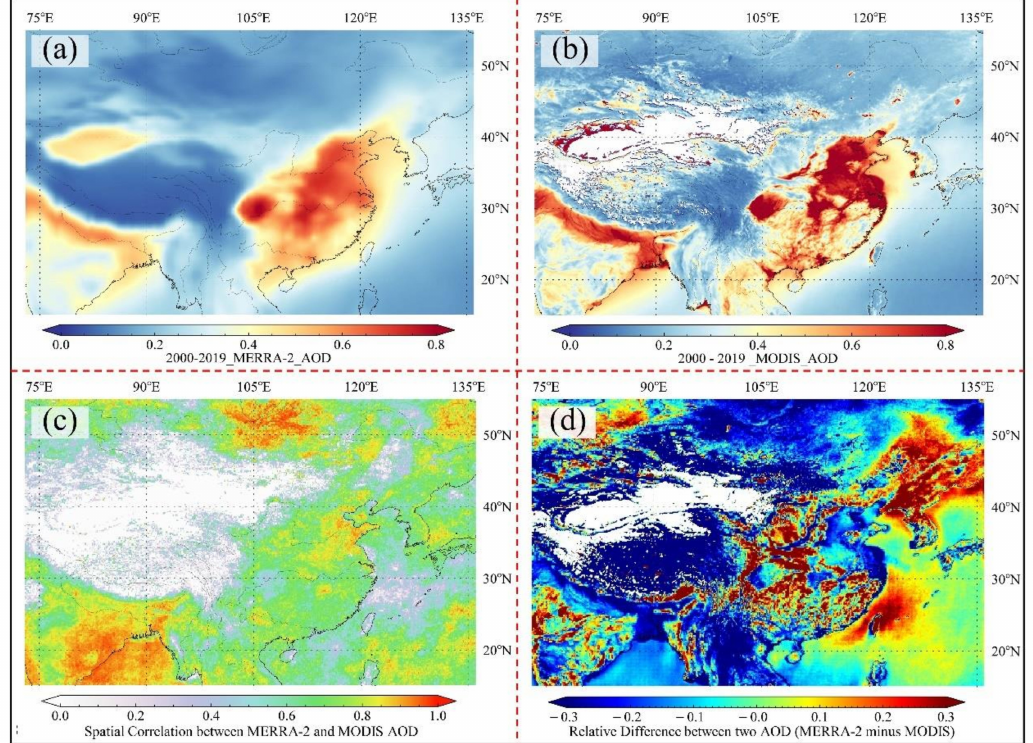
Figure 5. Spatial distribution of annual average AOD from ( a ) MERRA-2 and ( b ) MODIS; ( c ) spatial correlation and ( d ) relative difference between MERRA-2 and MODIS AOD values during